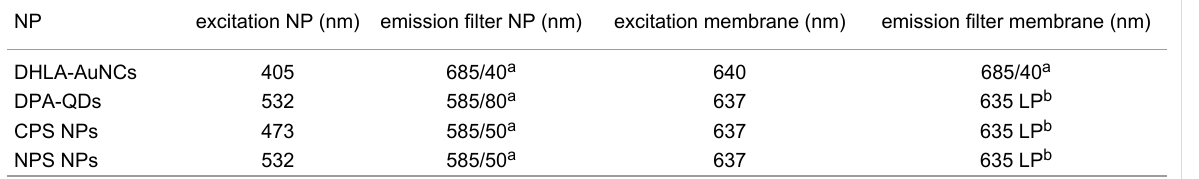
Table 3: Excitation and emission wavelengths used in the imaging studies.